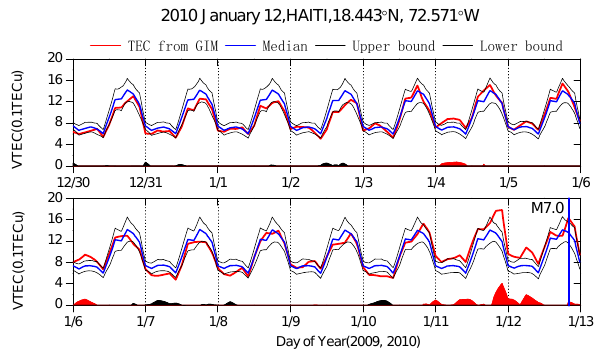
Fig. 2. Dst, F 10 . 7 , and K p indices during 30 December 2009 to 12 January 2010.